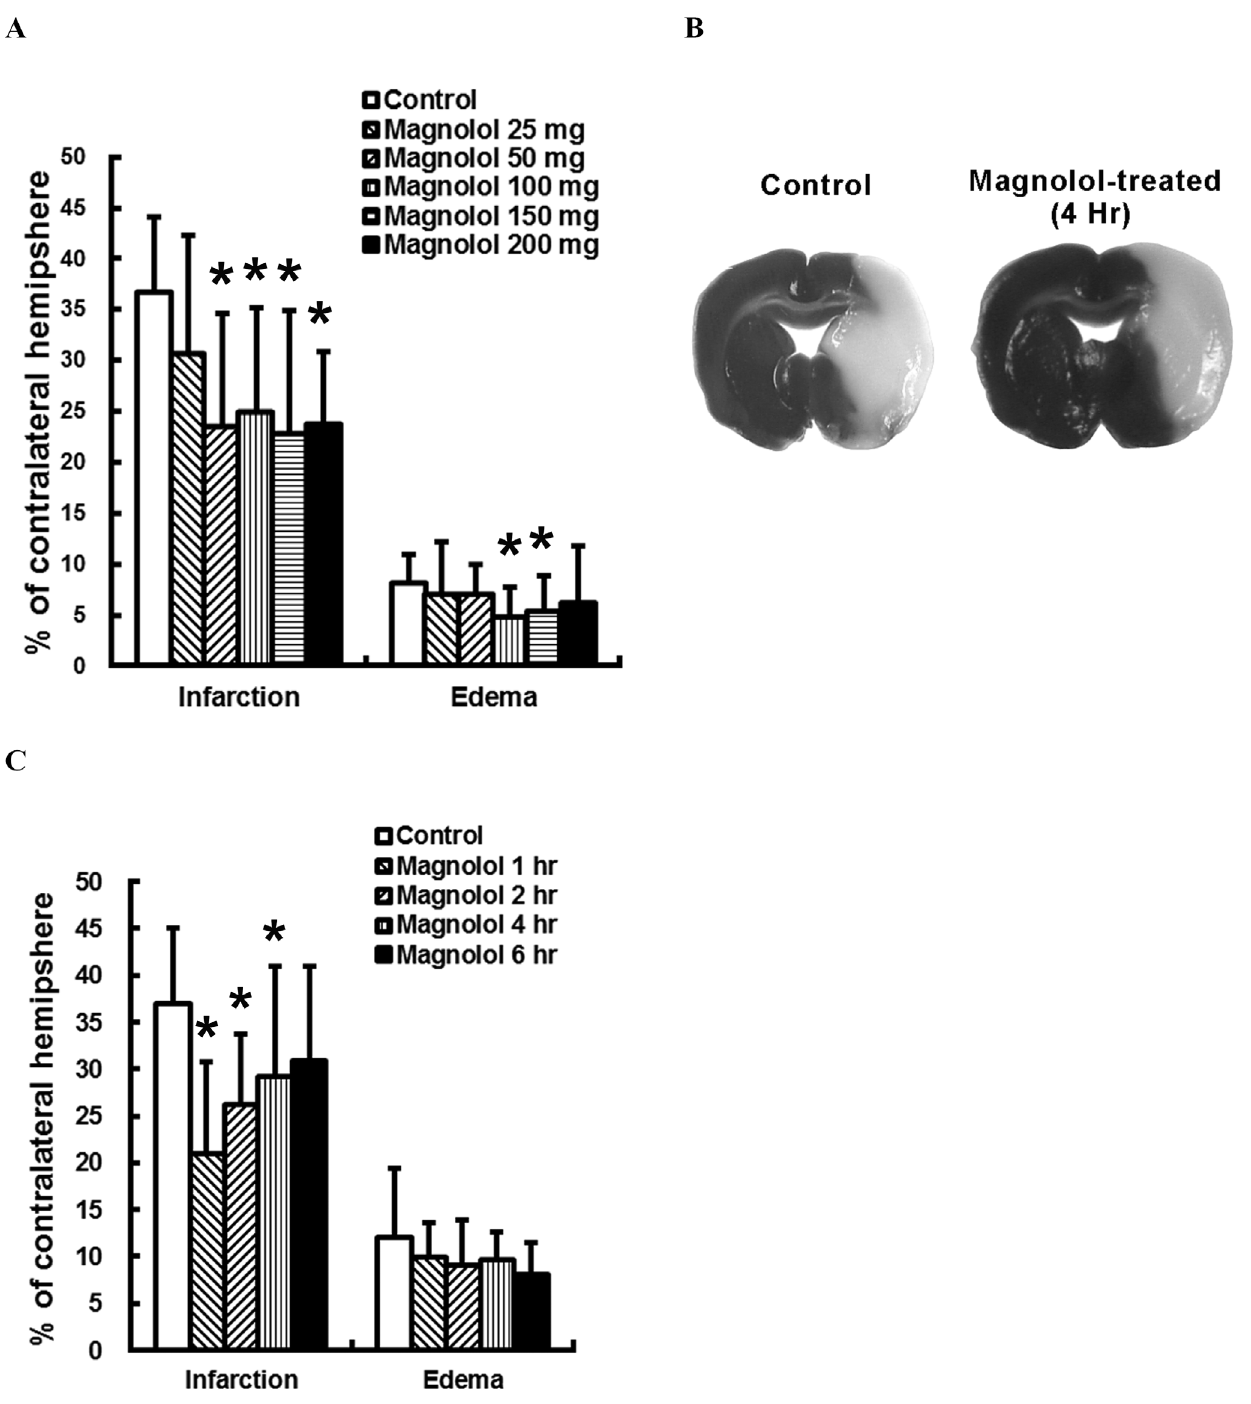
Figure 3. Magnolol reduced brain infarction in rats subjected to permanent middle cerebral artery (pMCAO) occlusion. Animals which were subjected to pMCAO and received an intraperitoneal injection of PEG 400 ( n =15) or magnolol, at 25 mg/kg ( n =13), 50 mg/kg ( n =11), 100 mg/kg ( n =8), 150 mg/kg ( n =9), or 200 mg/kg ( n =12), 1 hr before the ischemic insult. Infarct volumes were significantly reduced with magnolol treatment at 50–200 mg/kg (A), but not at 25 mg/kg. (B) The 2, 3, 5-Triphenyltetrazolium chloride (TTC)-stained coronal sections were from representative animals which received an intraperitoneal injection of PEG 400 or magnolol (100 mg/kg), at 4 hrs post-insult. Infarcts observed (pale region) involving the cerebral cortex and underlying striatum are substantially smaller in the magnolol-treated group. (C) Delayed treatment with magnolol (100 mg/kg) at 1 ( n =7), 2 ( n =7), or 4 hrs ( n =9), but not 6 hrs ( n =9), significantly reduced brain infarction, compared to controls ( n =30). The infarct volumes are expressed as a percentage of the contralateral hemisphere. * P , 0.05 vs PEG 400-treated rats. n , number of animals.